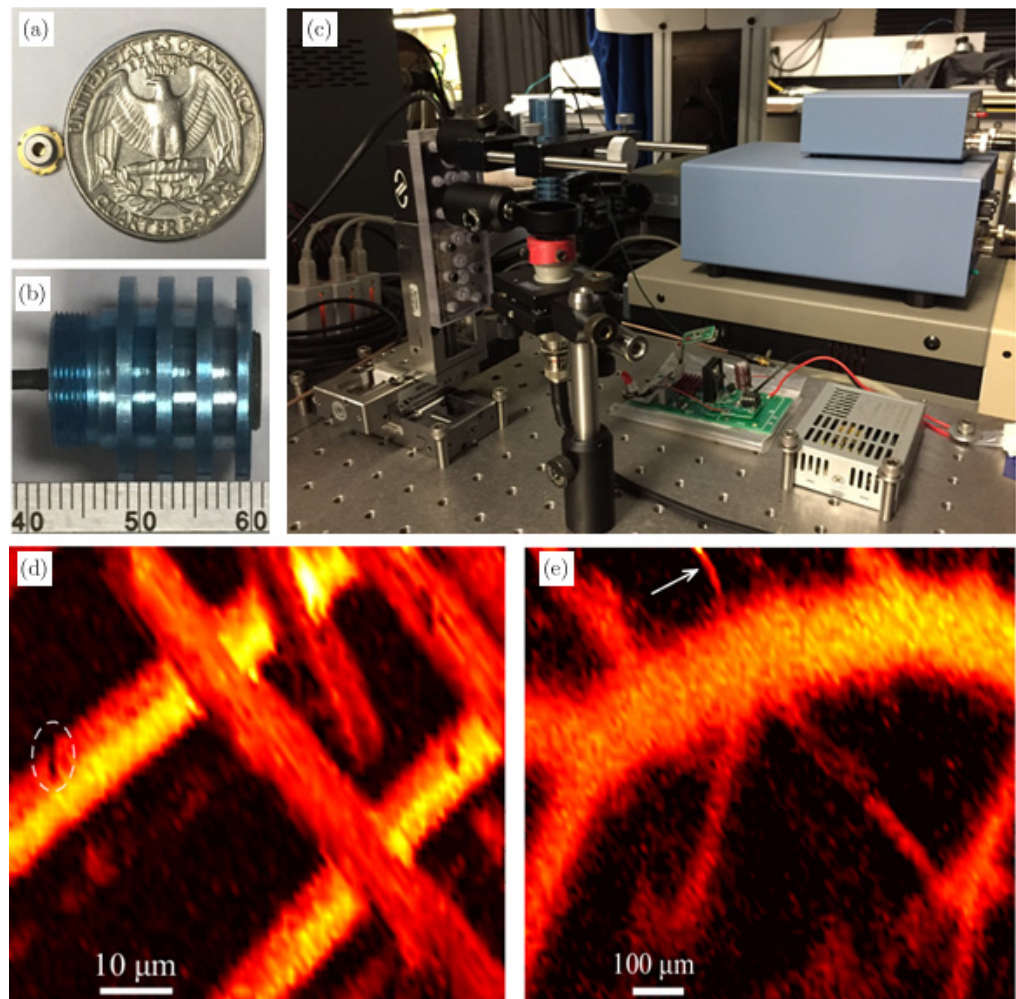
Fig. 7. (a) and (b) Photographs of the compact laser diode and assembled excitation source, (c) schematic of the pulsed VIS LD- PAM system, (d) cross-sectional image of the carbon ¯bers, and (e) ex vivo image of mouse subcutaneous microvasculature (images adapted from Ref.